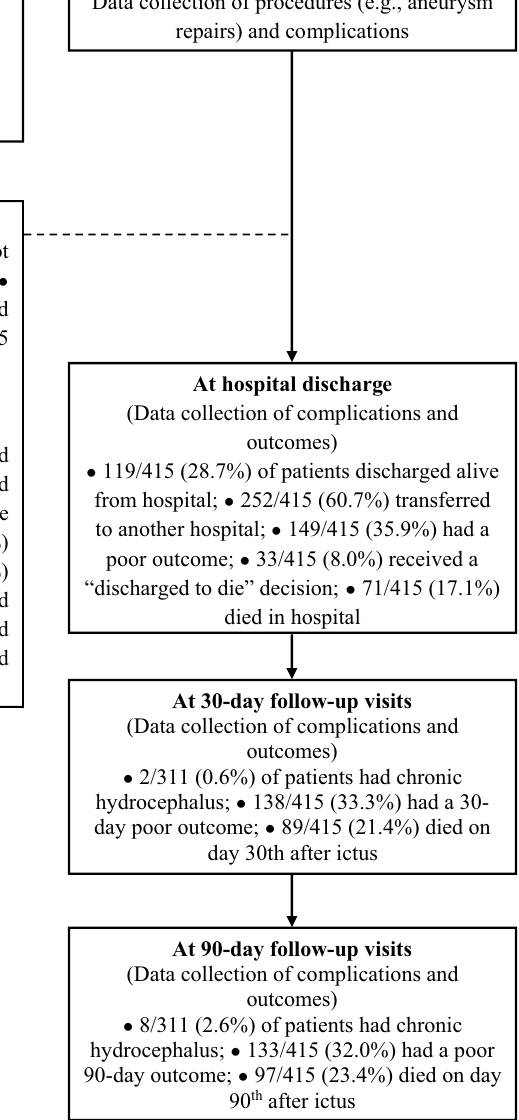
Figure 1. Flowchart of the study design and assessment occasions (“ discharged to die ”, defined as patients were in grave condition or dying and were classified with a modified Rankin Scale score of 5 (severe disability) at the time of discharge, DCI delayed cerebral ischaemia, GCS Glasgow coma scale, H&H Hunt and Hess grading scale, PAASH prognosis on admission aneurysmal subarachnoid haemorrhage grading scale, poor outcome defined as modified Rankin Scale scores of 4 (moderately severe disability) to 6 (death), SAH subarachnoid haemorrhage, WFNS World Federation of Neurosurgical Societies grading